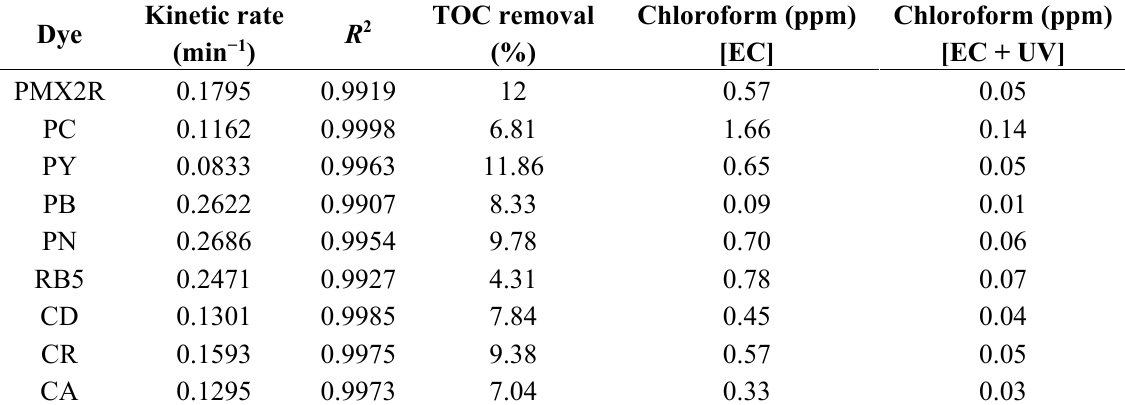
Table 2. Optimized electrochemical and photo-electrochemical treatments applied to 9 reactive dyes: kinetic rate, TOC removal and chloroform